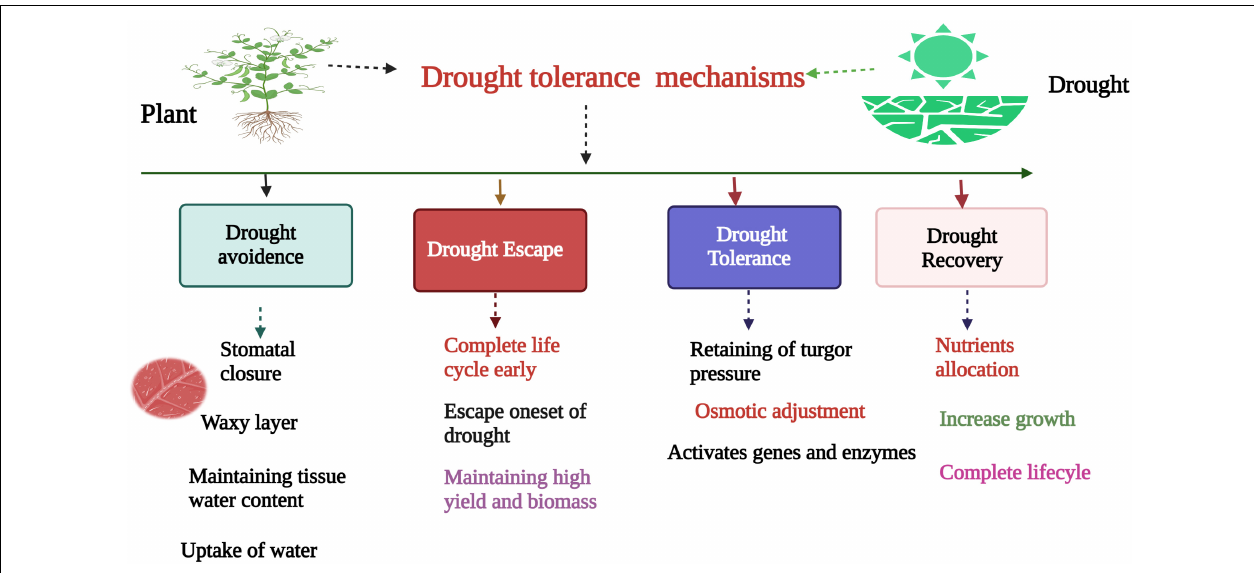
FIGURE 3 | Drought tolerance mechanism in ramie. The drought tolerance mechanism involves four steps, DA, DE, DT, and DR. Drought avoidance involves, stomatal closure, waxy layer, maintaining water contents in tissues, and enhance water uptake. Drought escape involves the early completion of life cycle before initiation of drought episodes. Likewise, drought tolerance involves, osmotic adjustment, and genes and enzymes activation. Last step is drought recovery which involves the improvement of growth due to allocation of nutrients and complete life cycle.